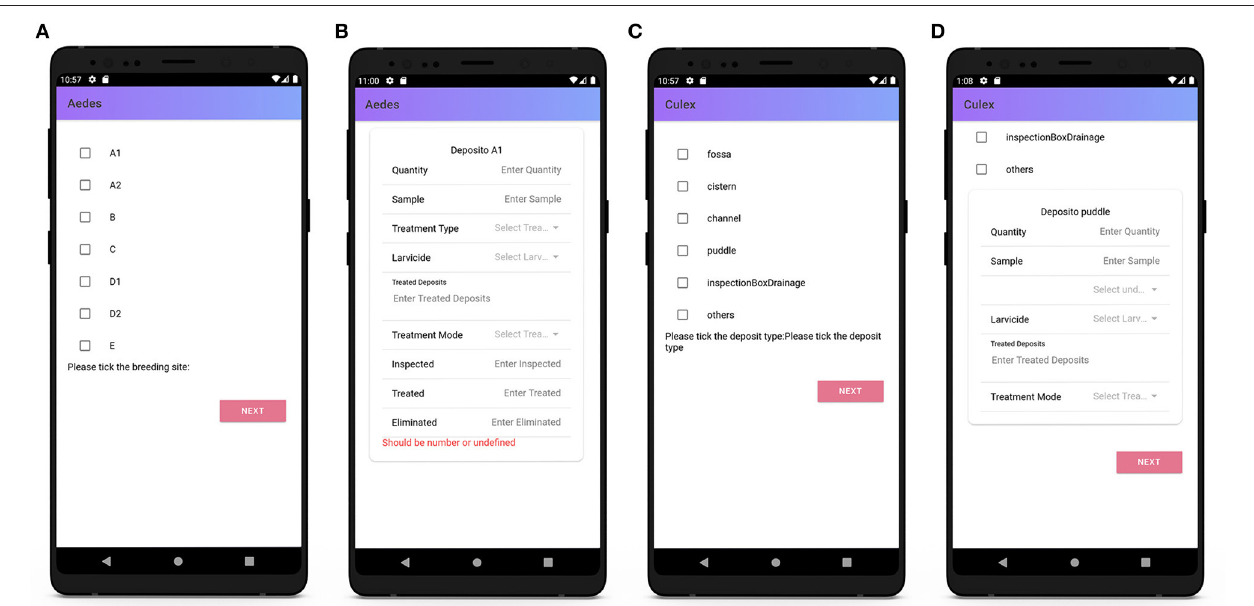
FIGURE 8 | Surveillance agents’ mobile application: entomological section of the form. (A) Aedes form, (B) infected container A1, (C) Culex form, and (D) infected puddle.